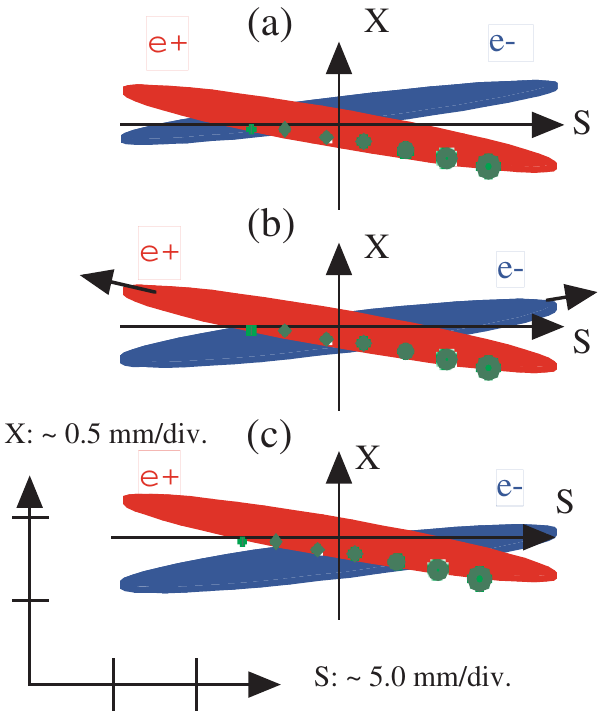
FIG. 10. (Color) Schematic top view at the IP with a horizontal crossing angle. The axis S indicates the longitudinal direction and X the horizontal one. The scale factor for both directions is about 1 = 10 . Each figure indicates that the collision occurs with a positive horizontal offset (a), around zero offset (b) and a negative one (c). The red indicates a positron bunch and the blue an electron bunch. The green circles image the wakefield due to the electron cloud, where the size corresponds to the strength of the